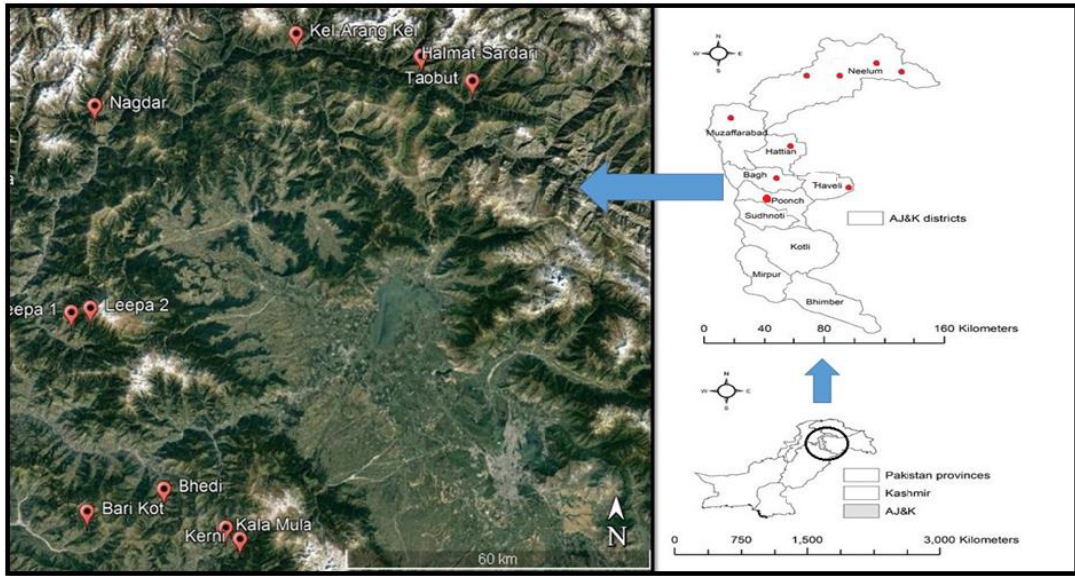
Figure 5. Map of the study area ( right ) and satellite imagery ( left ) of the sampled bean producing locations in AJK.